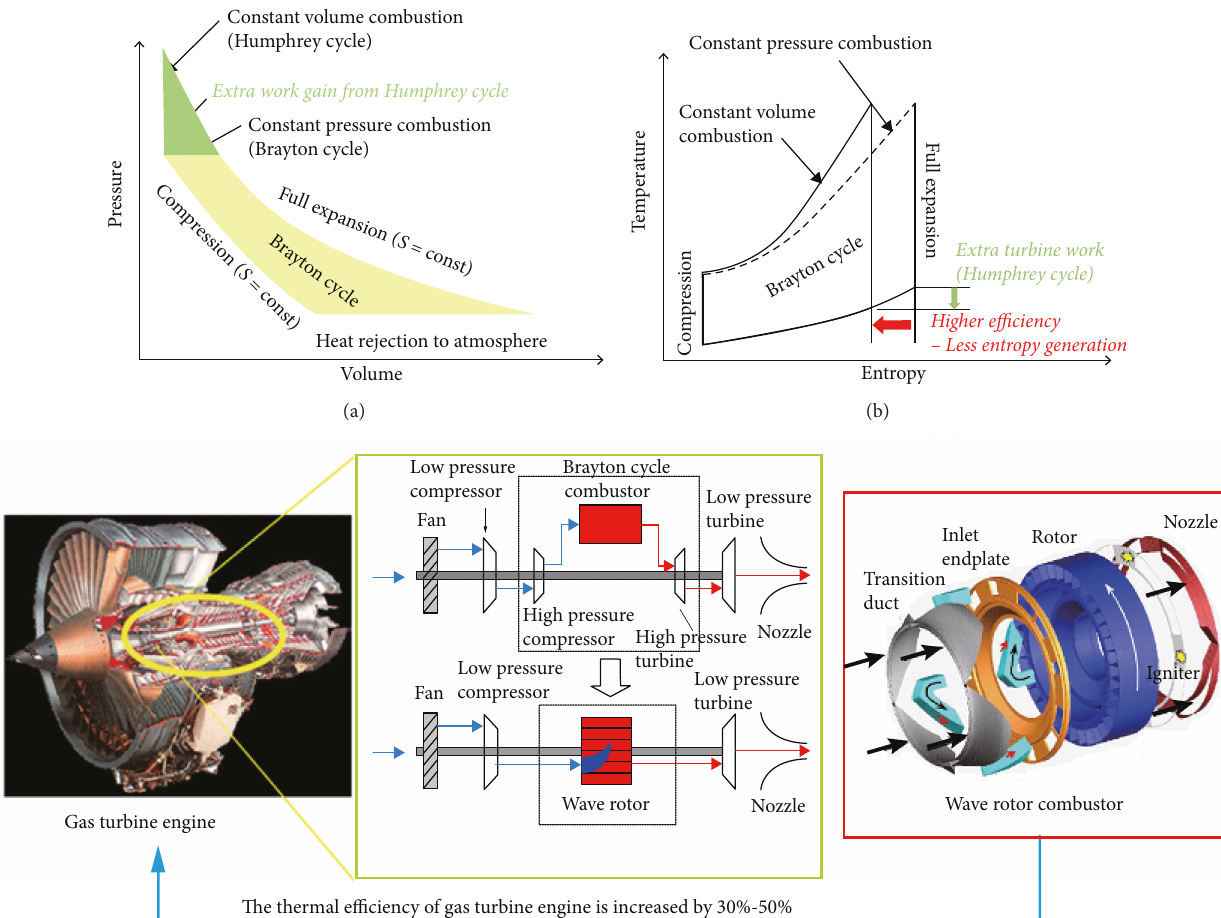
Figure 1: Comparison between the ideal Brayton cycle and the ideal Humphrey cycle on P-V diagram (a) and T-S diagram (b) WRC location in a turbojet engine